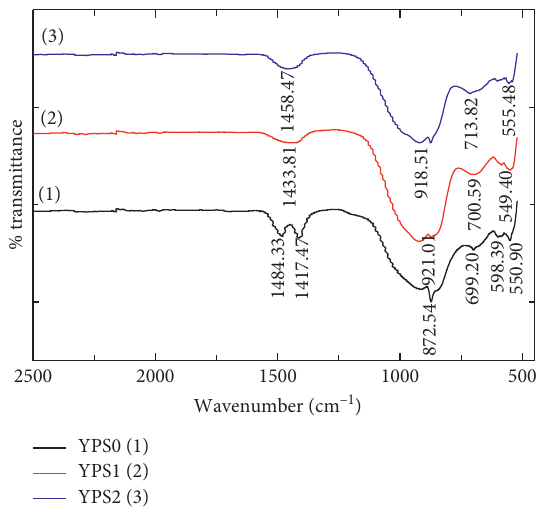
Figure 1: FTIR spectra of YPS samples.